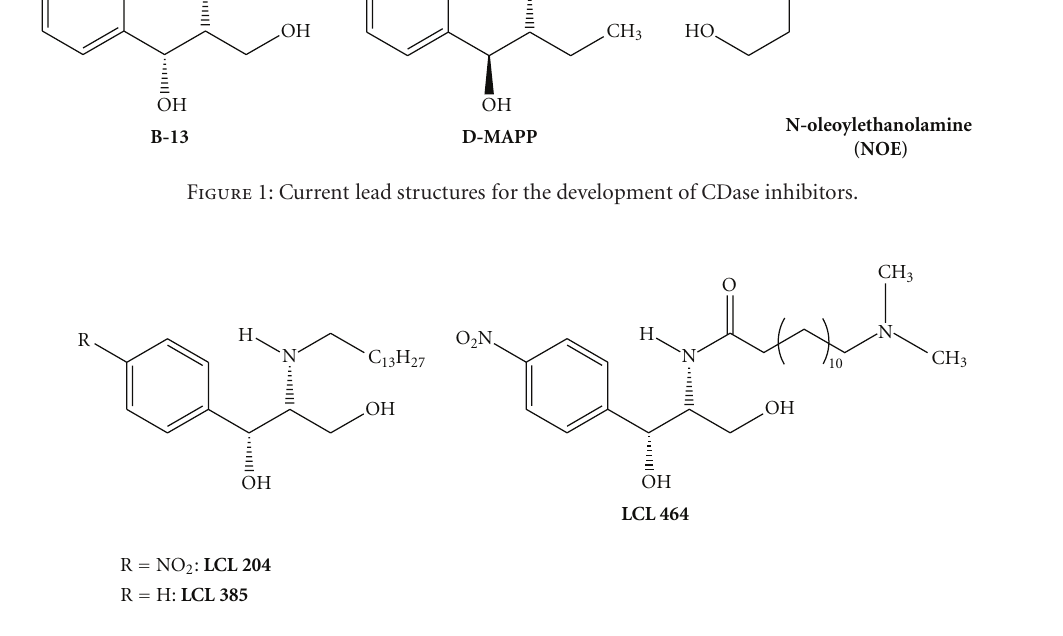
from human [17] and mouse [18] have been cloned. The enzyme is localized to the lysosomes [19] or is secreted extracellularly